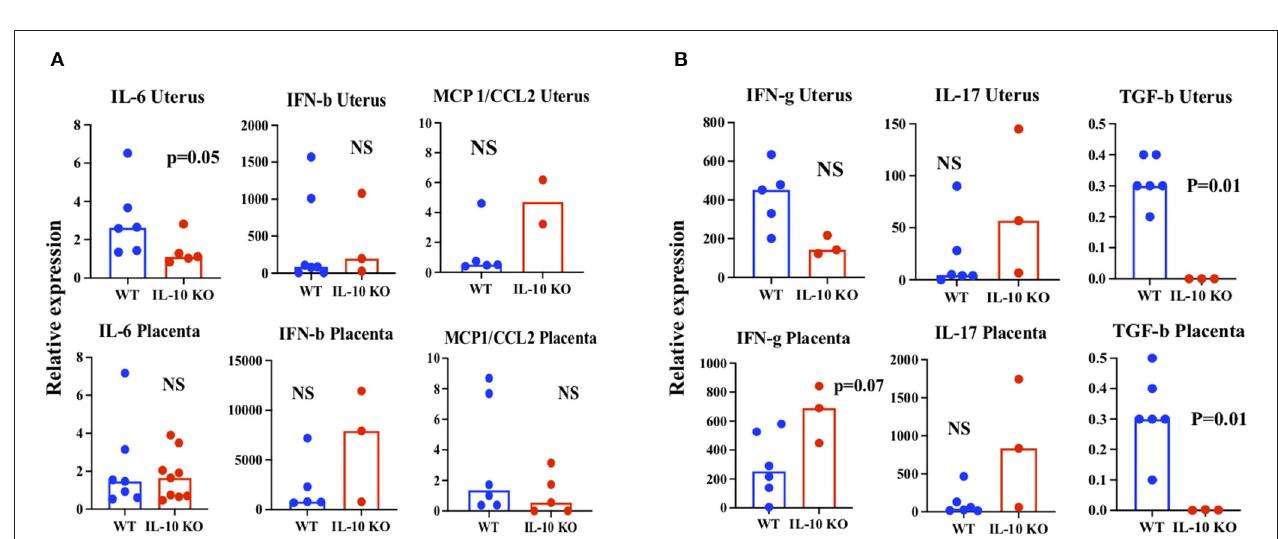
FIGURE 4 | RNA expression of cytokines in WT vs. IL-10 KO tissues. Tissues from WT (blue) or IL-10 KO (red) mice who were infected on ∼ day 10 of pregnancy and harvested 8 days later were harvested and RNA extracted to determine expression by QT-PCR as in Figure 1 . Each symbol denotes a single tissue from a unique mother. (A) “Innate immunity” cytokines IL-6 (left), Interferon- β (middle) and CCL2 (right). (B) “Adaptive immunity” cytokines Interferon– γ , IL-17, Transforming growth factor- β . Upper panels, uterus. Lower panels, placenta. Bars—medians. p values analysis of significance utilized the Mann Whitney test. NS, not significant at the p < 0.05 level. Trends ( p < 0.1) are